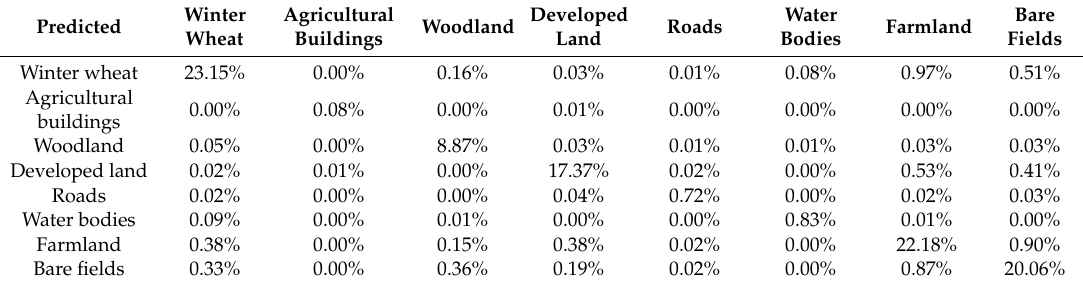
Table 4. Confusion matrix for the CEM models.